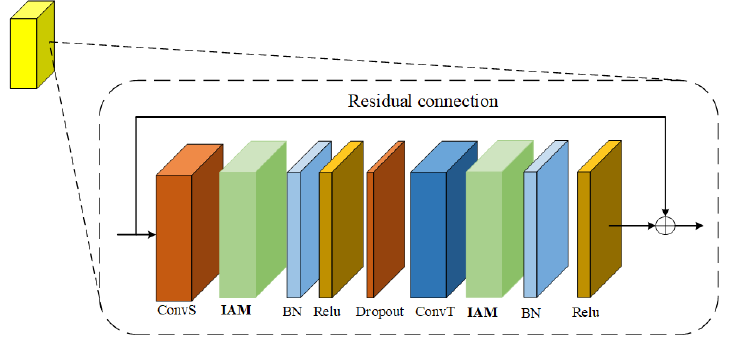
Figure 7. Adaptive graph convolution model with importance attention module.